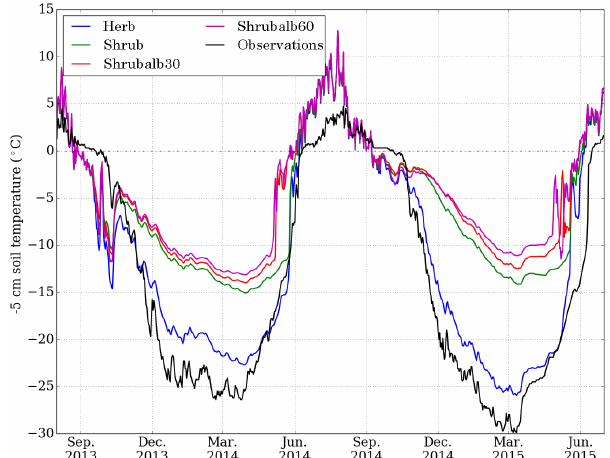
Figure 11. Simulation of ground temperature at 5cm depth with the herb , shrub , and shrubalb scenarios, for the 2014–2015 winter. Measurement at our meteorological station, on herb tundra in a low center polygon area, is also shown for